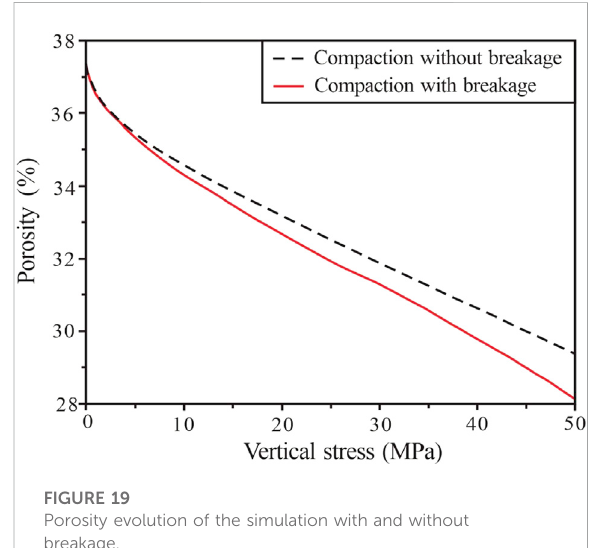
FIGURE 19 Porosity evolution of the simulation with and without